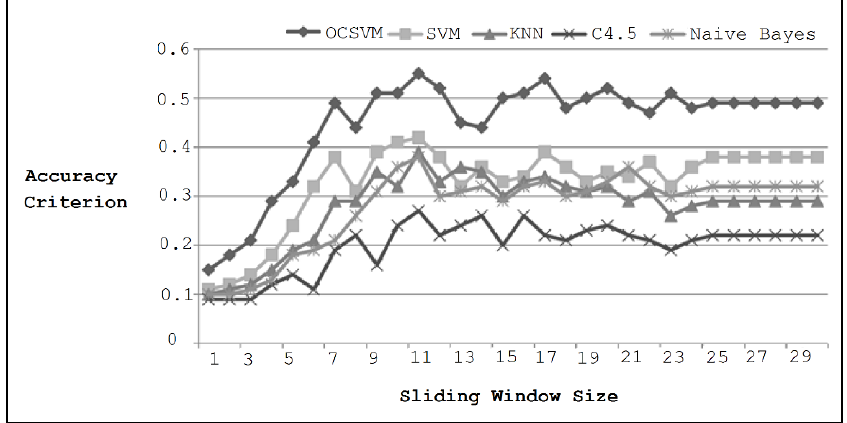
Figure 9. Impact of changing sliding window size on classifiers according to accuracy